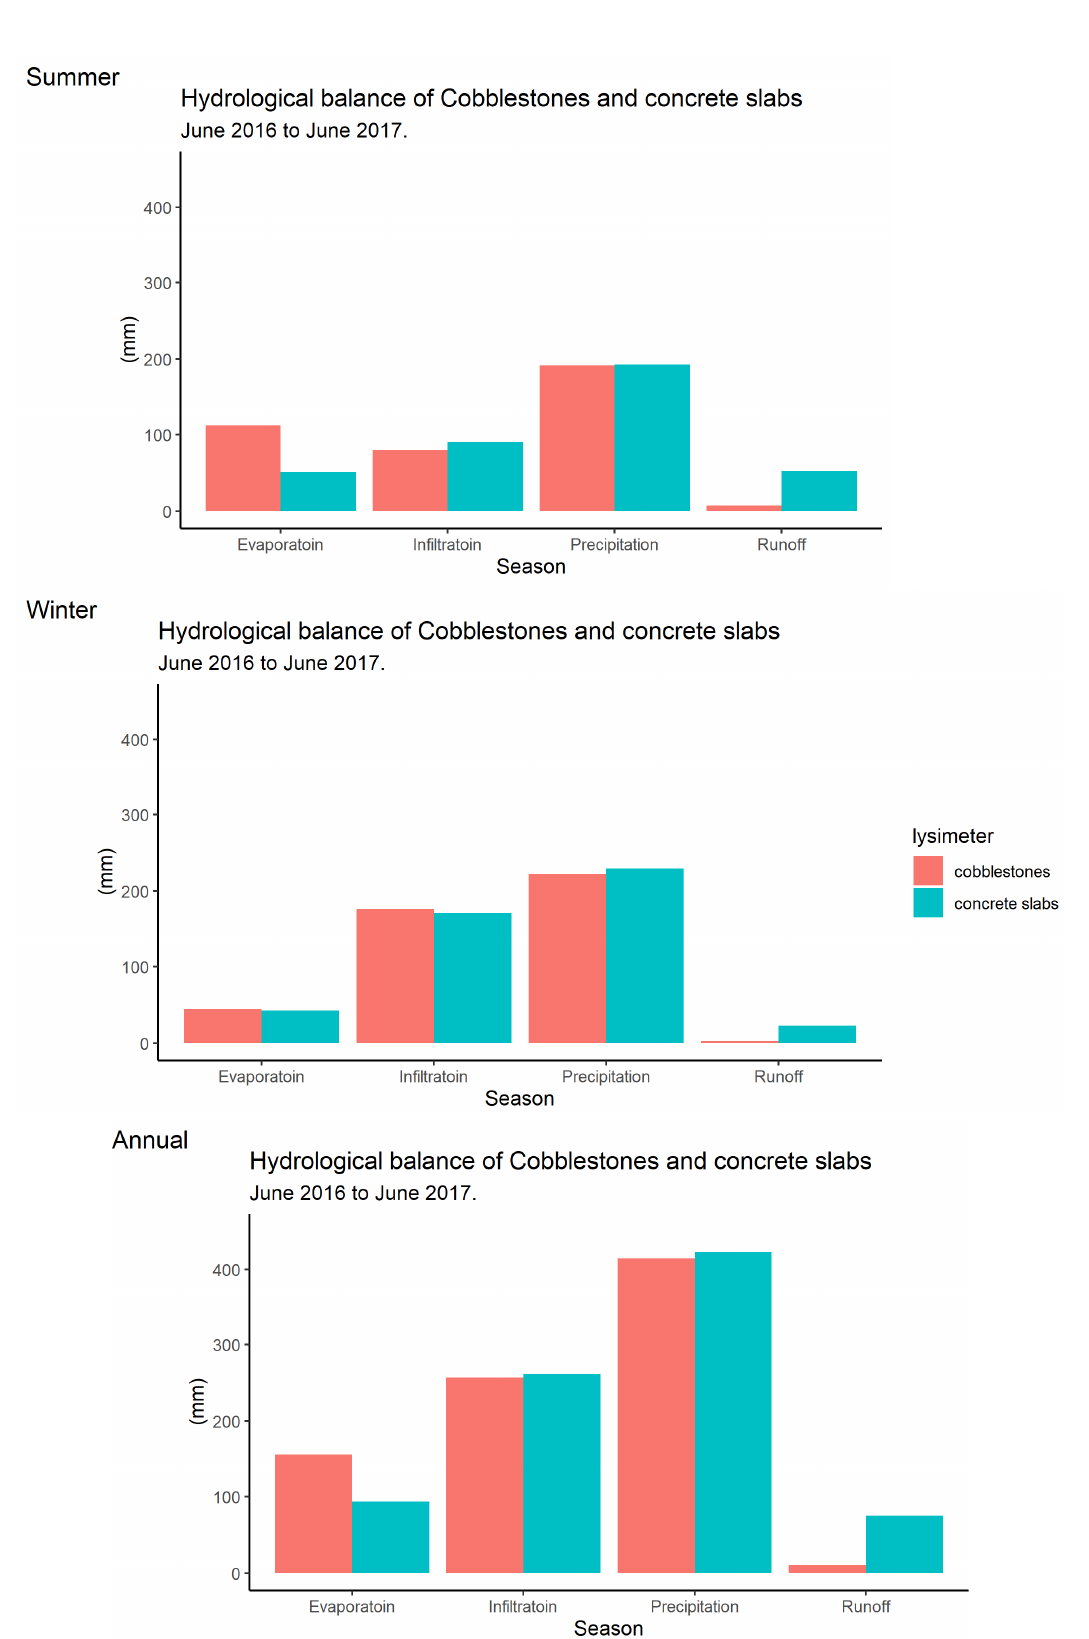
Figure 3. One-year (June 2016 to June 2017) measured hydrological balance of paved surfaces in Berlin, Germany, summer—May to October, and winter - November to April (mm).